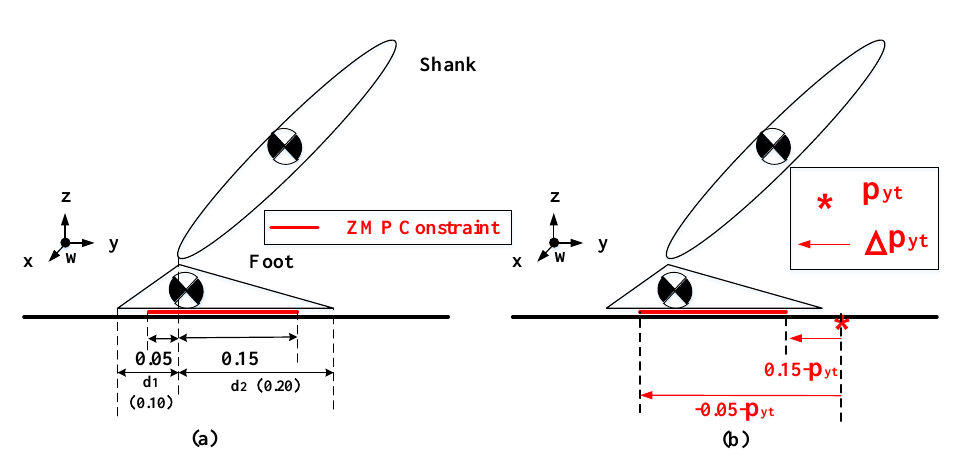
Figure 7. ( a ) the ZMP (zero moment point) limitation in the y -direction p ylim ∈ ( − 0.05, 0.15 ) (m); ( b ) the ∆ p yt added to p yt to maintain the ZMP